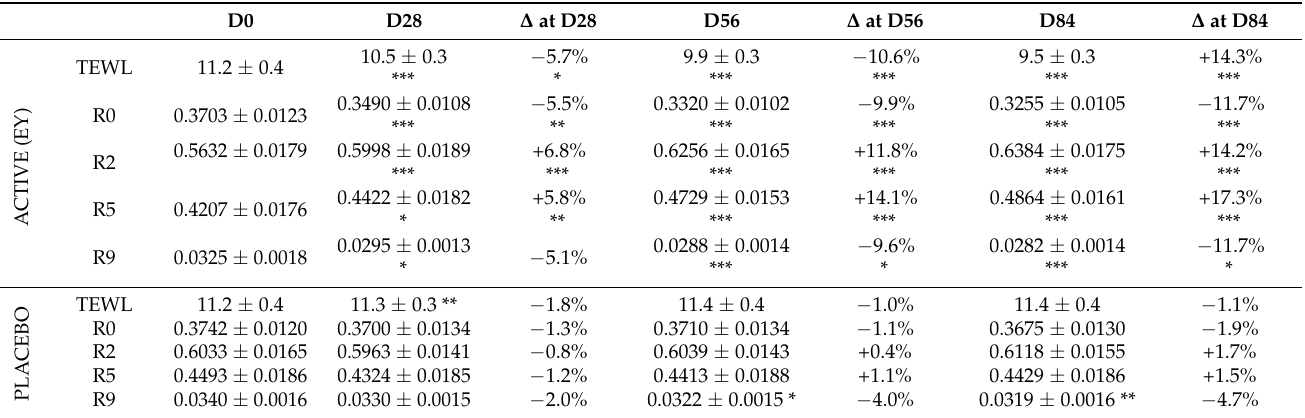
Table 2. Effect on TEWL and skin